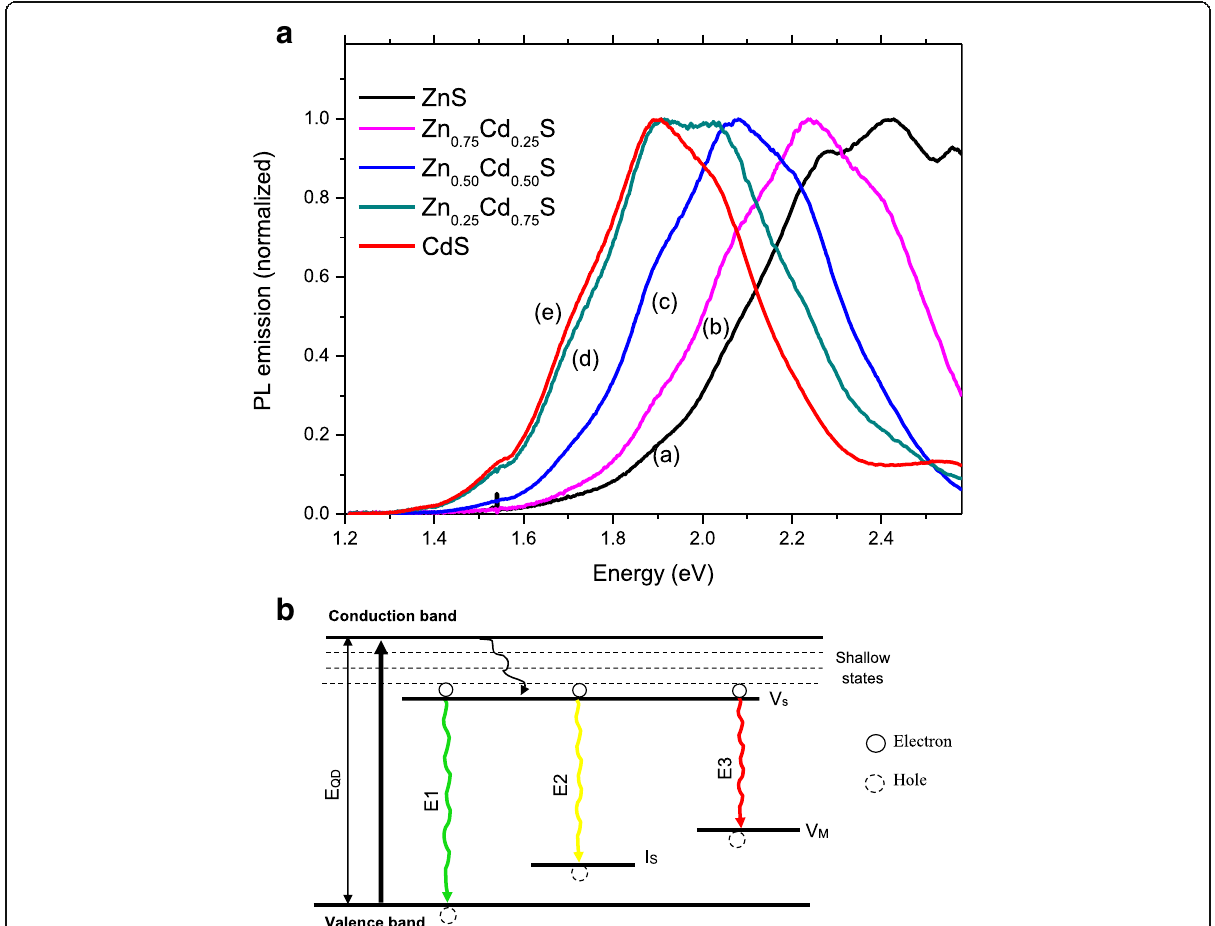
Fig. 2 Photoluminescence spectroscopy of conjugates. a PL emission spectra for Zn x Cd 1 − x S ( x = 1.0 (a) , 0.75 (b) , 0.50 (c) , 0.25 (d) , and 0 (e) . b The energy band structure suggested for three main emissions of alloyed Zn x Cd 1 − x S quantum